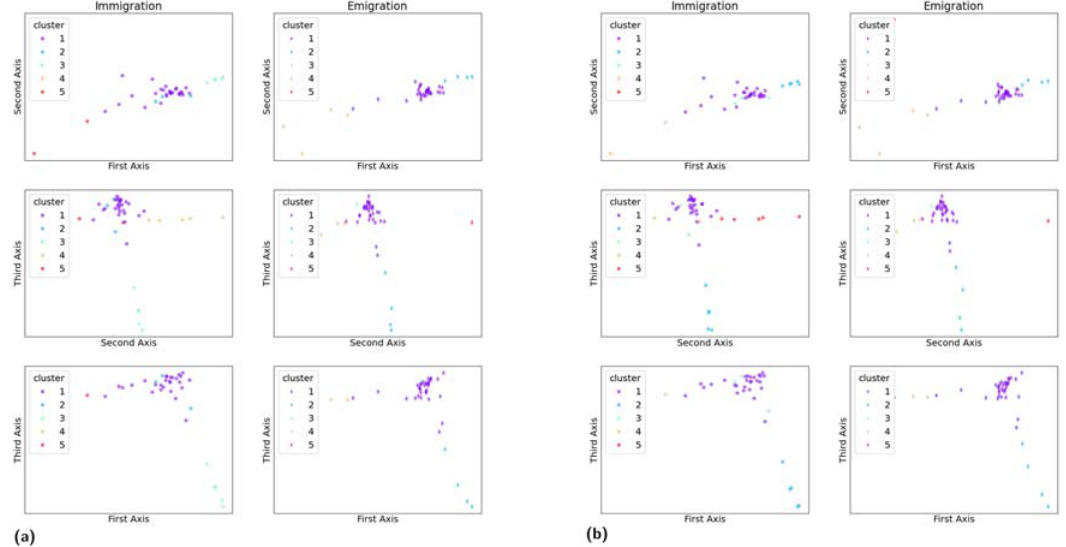
Figure A4: Pairwise plots of the correspondence analysis results based on the fi rst three singular vector pairs, enhanced with the cluster memberships, illustrated by di ff erent colors. ( a ) 2015 and ( b )